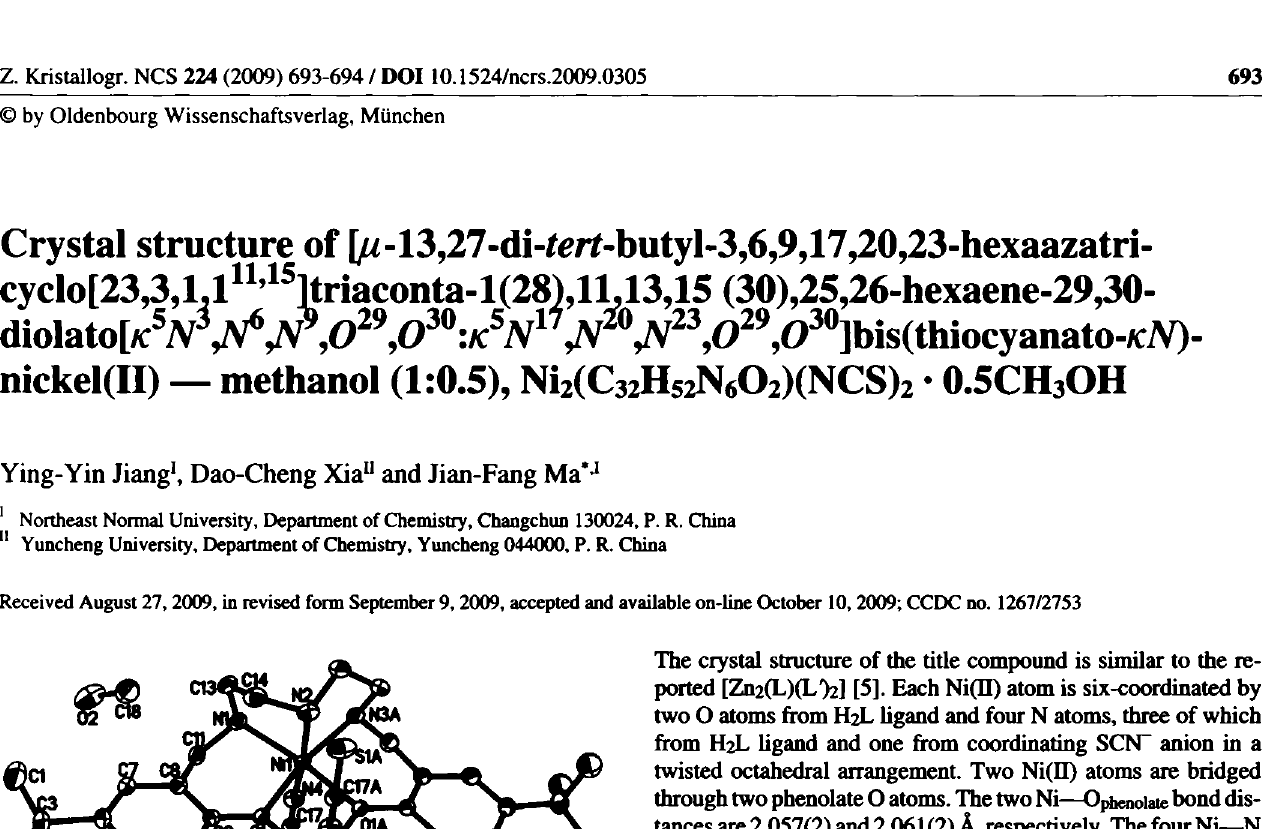
Table 1. Data collection and handling.